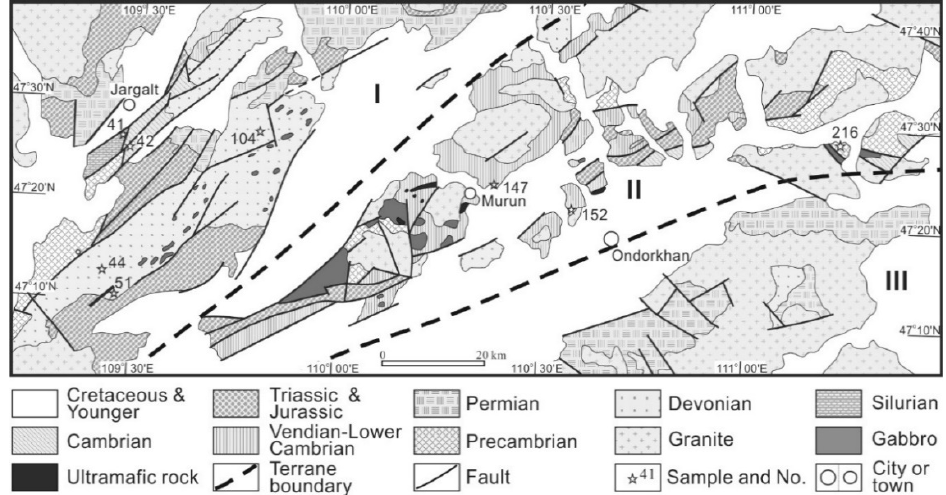
Figure 4. Geological map of the Ondorkhan area in northeastern Mongolia (modified from [36]).